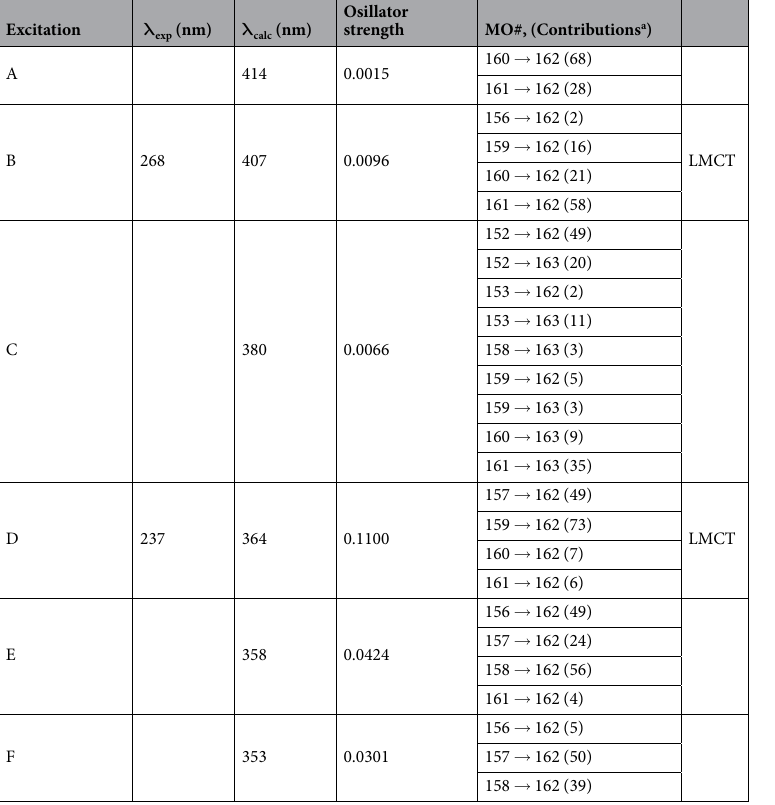
periphery of the molecule. For complex 5 , electrons distributed around the metal migrate to neighboring phenyl groups: λ = 243 nm (HOMO to LUMO + 3) and λ = 292 nm (HOMO to LUMO). Similarly, for complex 5 , the high energy is caused by MLCT of HOMO to LUMO + 3, and the neighboring λ = 292 nm (HOMO to LUMO) by gold center to the surrounding phenyl groups of the the dppe ligand. In contrast, complexes 3 , 4 , 6 and 7 show mainly LMCT transitions. For 3 , high energy peaks ( λ = 256 nm) were observed in quinoxaline-to-gold charge transfer (HOMO-3 to LUMO and HOMO to LUMO + 1) and low energy peaks were considered as transition from benzopyridine to gold center (HOMO-2 to LUMO and HOMO-1 to LUMO, Fig. S35). Complex 4 is largely due to the transition of HOMO-2 to LUMO for λ = 241 nm, from the two phenyl rings of the dppe ligand to the gold, and HOMO to LUMO for λ = 294 nm from the phenyl to gold (Fig. S36). For 6 , λ = 237 nm correspond to, HOMO-2 to LUMO, which is consistent with a LMCT transition based on the localization of the HOMO-2 and the LUMO and λ = 268 nm is as a result of a similar transition, HOMO to LUMO (Fig. 4). Complex 7 also possess a similar profile with λ = 234 nm corresponding to HOMO-2 to LUMO + 1, which is a LMCT transition, and λ = 285 nm, resulting from HOMO to LUMO with LLCT transition (Fig. S37). Although the complexes use